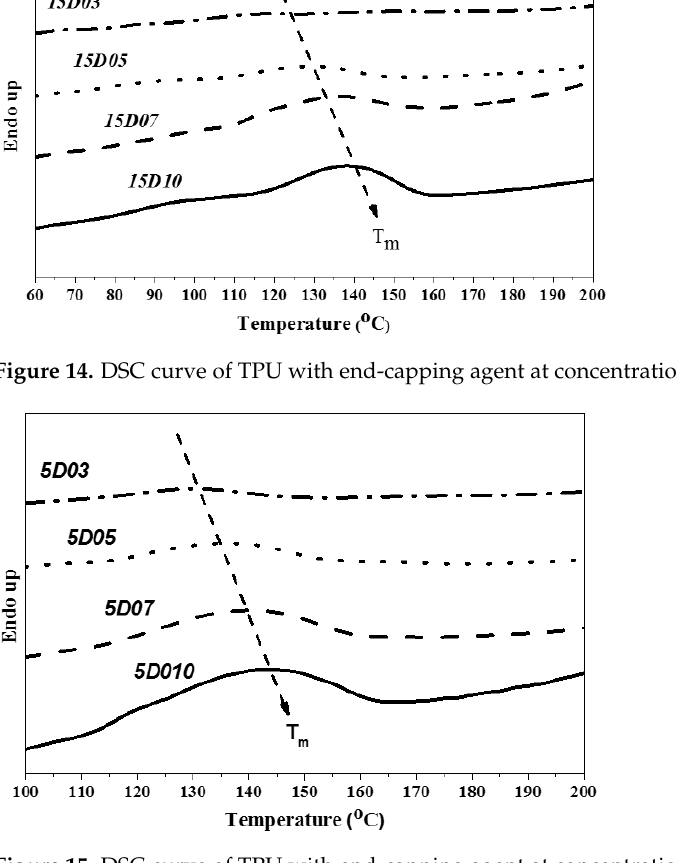
Figure 15. DSC curve of TPU with end-capping agent at concentration of 15 phm. Table 6. DSC data of